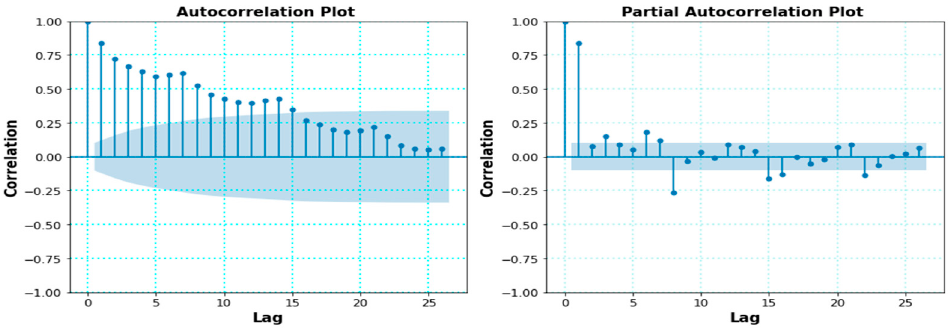
Figure 9. The daily time series AFC and PACF plot before the series transformation. The SARIMA model (p, d, q) (P, D, Q) m is considered appropriate for handling the daily transformed time series. After checking the different combinations of the candidates’